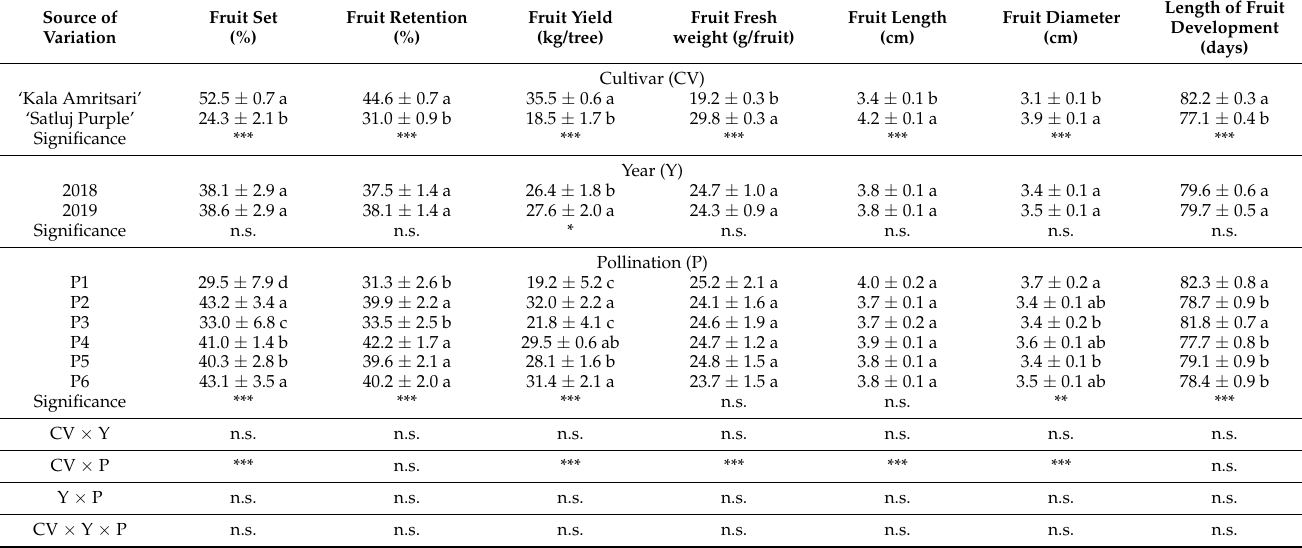
Table 2. Significance of the effects of the cultivar, the year, the pollination treatment, and their interaction (assessed with three-way ANOVA) on the fruit set, retention, yield, fresh weight, length, and diameter, and on the length of the fruit development stage. Within each column and separately for the source of variation (cultivar, year, and pollination), mean values followed by the different letters represent significant differences ( p < 0.05) according to Tukey’s HSD test.